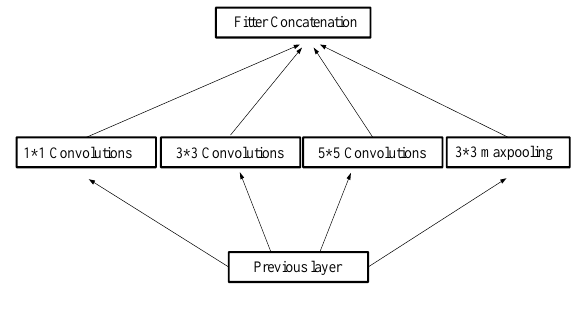
Figure 6 . Original Inception